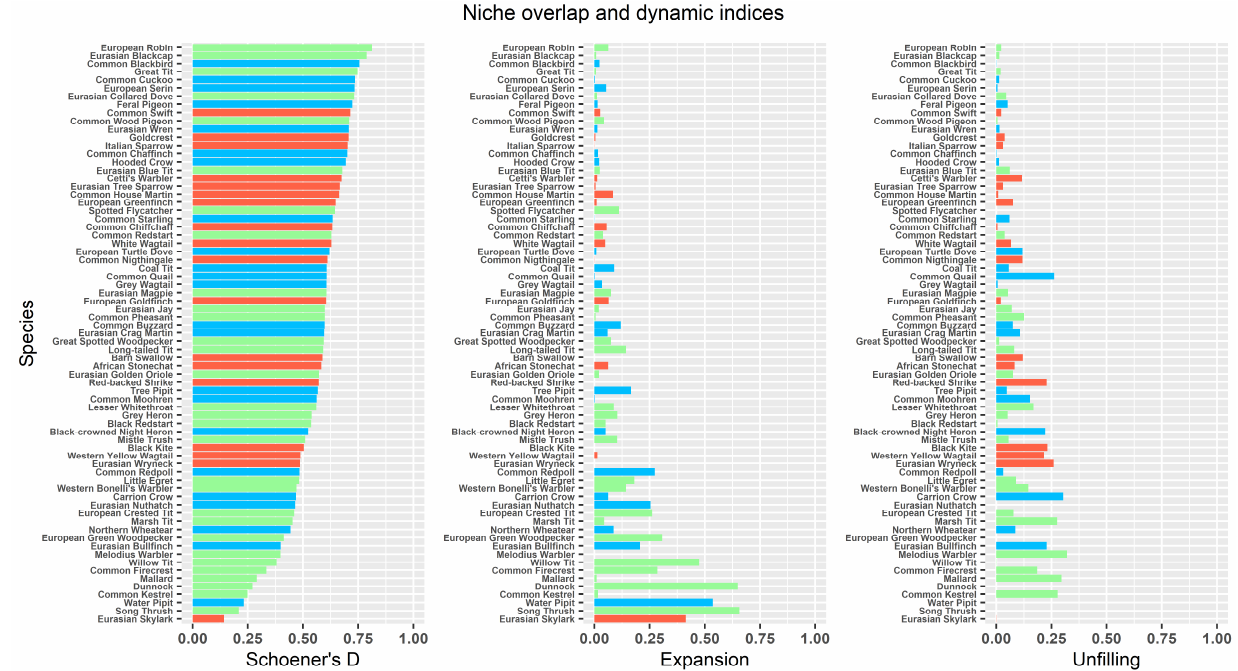
Figure 4. Niche overlap and dynamic indices between T 1 (1992–95–96) and T 2 (2015–16–17). The Schoener’s D index (observed niche overlap), the expansion and unfilling (dynamic indices) are given for each species. The length of the bar is proportional to the value of the index. Species were reported with the common name [97] and listed in descending order in respect to the Schoener’s D value. Bar colors reflect species trend: increasing populations, green; non-significant population trends, light blue; decreasing populations, red.